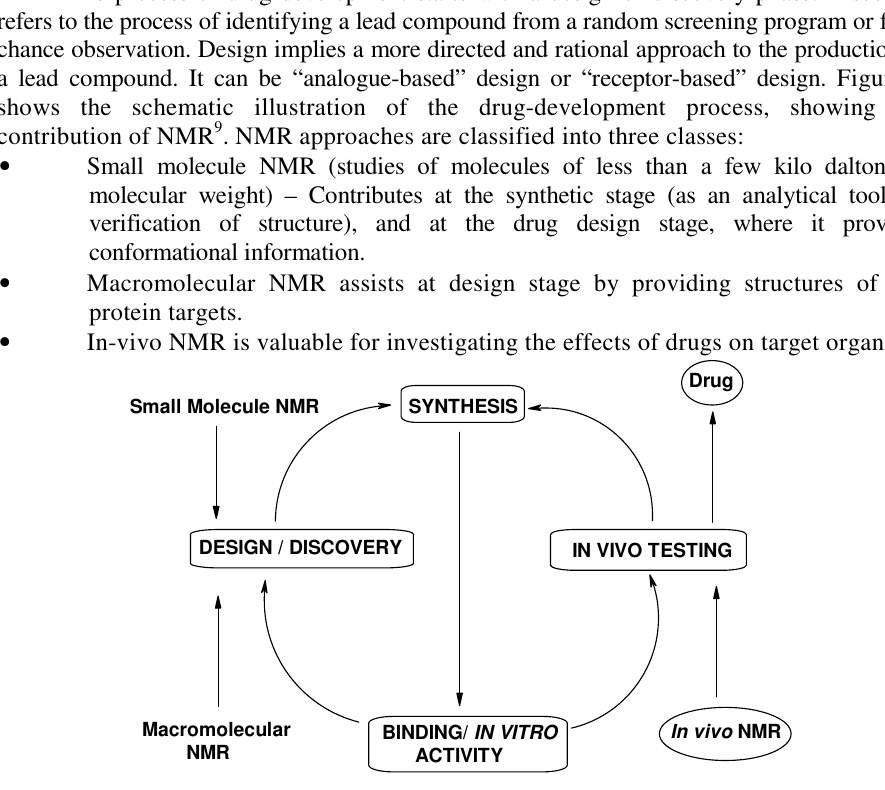
Figure 1. Schematic illustration of the drug development process, showing the contribution of